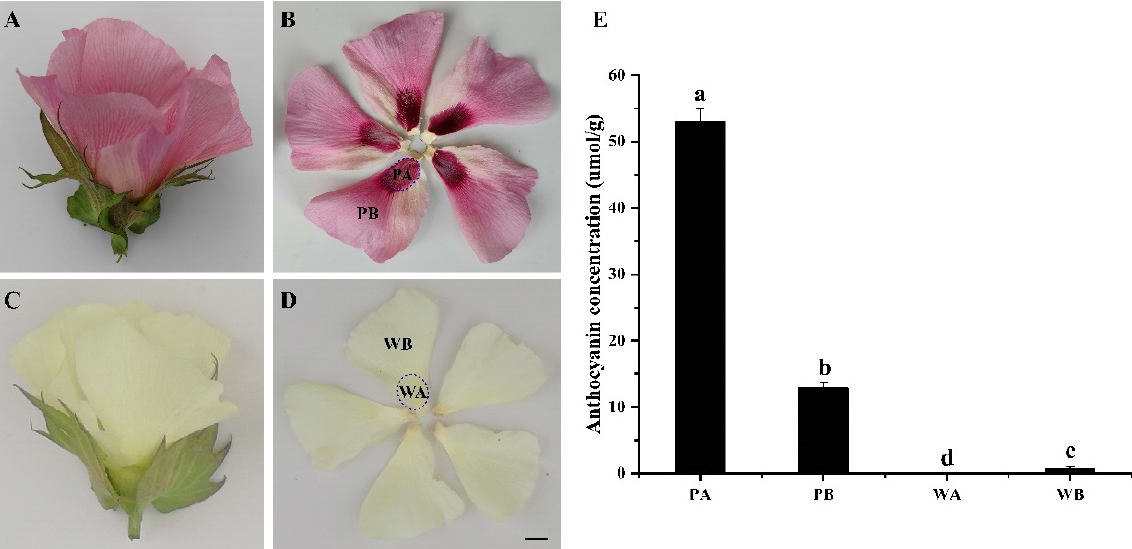
Figure 1. The color phenotypes characterization and total anthocyanin content of different parts of petals of varieties XinLuZao 74 (X74) and Pink Flower ( PF ). ( A , B ) Phenotypes of PF mutant petals. ( C , D ) Phenotypes of X74 petals. ( E ) Total anthocyanin concentration in different regions of X74 and PF petals. All data are shown as mean ± SE ( n = 3). Different letters represented statistically significant differences (one-way ANOVA, p < 0.05). Scale bar: 1 cm. PA, PB, WA, and WB represent the spot region and non-spot region of PF and X74 petals, respectively.